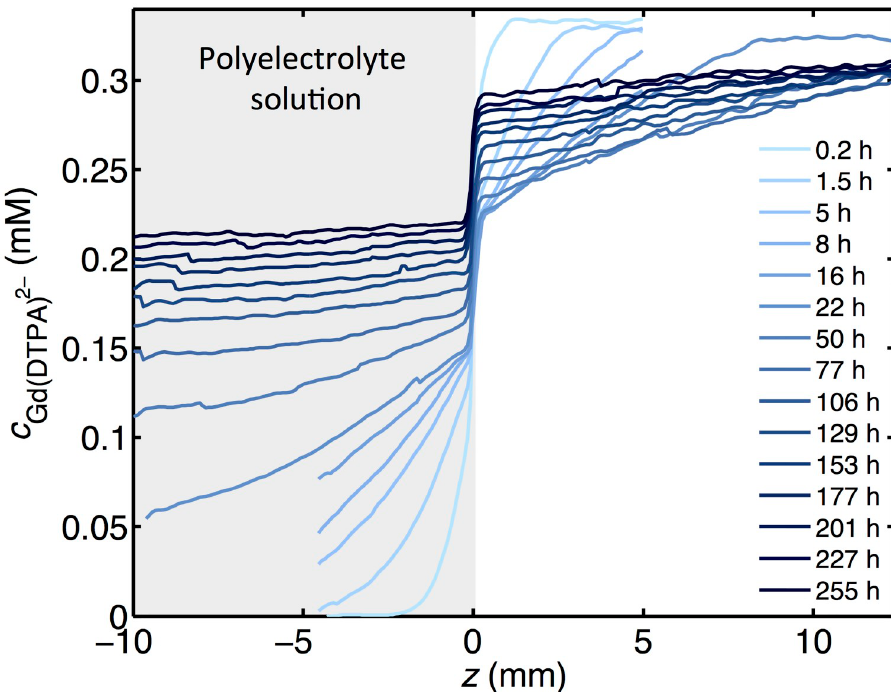
Fig 2. Experimental concentration profiles. Concentration profiles of Gd(DTPA) 2 − at different times in the salt solution and the polyelectrolyte solution with FCD = -108 mM ( z < 0). Gd(DTPA) 2 − was injected in the salt solution at t = 0 and the data was acquired using μ MRI. The (small) decrease of the concentration of Gd(DTPA) 2 − at longer times on the right hand side is due to the finite volume of the salt solution.